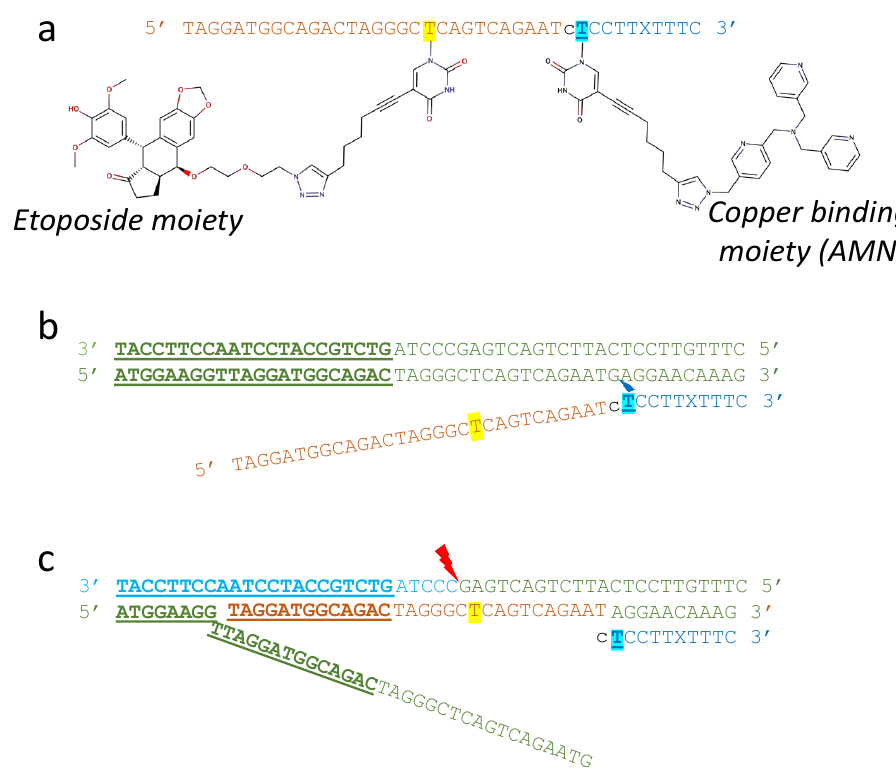
Figure 5. A 41 mer comprising a 30 mer etoposide-OTI coupled to a 10 mer AMN-TFO. ( a ) Depiction of a 41 mer, in which a 30-mer WC-OTI (orange letters with etoposide attached to yellow highlighted T) has been linked (single c in black) to a ten nucleotide TFO (blue letters) with a copper binding artificial metallo-nuclease (AMN) at the 5′ end. The copper binding AMN moiety is covalently at- tached to a cyan highlighted T. Note the X is a nucleotide designed to recognize a C in a TFO [68]. ( b ) the OTI recognizes a DNA-duplex (green letters) and the AMN cleaves one strand of the duplex (blue lightning bolt). ( c ) The rest of the strand-invading OTI (orange letters) can now strand invade and cleave the target oncogene (red lightning bolt–as in Figure 4b). 4. Using OTIs to Exploit ‘Safe’ DNA Repair Pathways in the CNS DNA-cleavage stabilizing anti-cancer drugs (Table 1) kill cancer cells by creating multiple double-stranded DNA-breaks. The bacterial immune CRISPR/Cas systems cuts up (makes double stranded DNA-breaks in) the DNA of invading bacteriophage. How- ever, while making double stranded DNA-breaks for gene editing has advantages, it is potentially hazardous and therapy related leukemias have been reported in the literature [10,29,55,56,69]. For this reason, we suggest utilizing single stranded breaks for neuro- degenerative in vivo gene editing efforts with OTIs. Chatterjee and Walker, reviewing DNA damage, repair and mutagenesis [1], de- scribed how spontaneous deamination of 5-methyl cytosine produces thymine (Figure 6). The resulting G-T base-pair is recognized by thymine DNA-glycosylase and repaired. Ap- parently, GC to AT transitions account for at least one third of single-site mutations re- sponsible for hereditary diseases in humans [1], therefore ‘correcting’ such GC to AT mu- tations seems to be a reasonable initial target for OTI therapeutics. Although the 5′-flank- ing base pair to G·T mismatches influences the rate of removal of thymine [70] we assume, for the sake of simplicity in this review, that the G-T mismatches will eventually be re- paired in cells in the CNS. Further experiments will need to be performed to demonstrate this; however, other DNA repair pathways [1] might be exploited for ‘safe’ gene editing in the CNS.